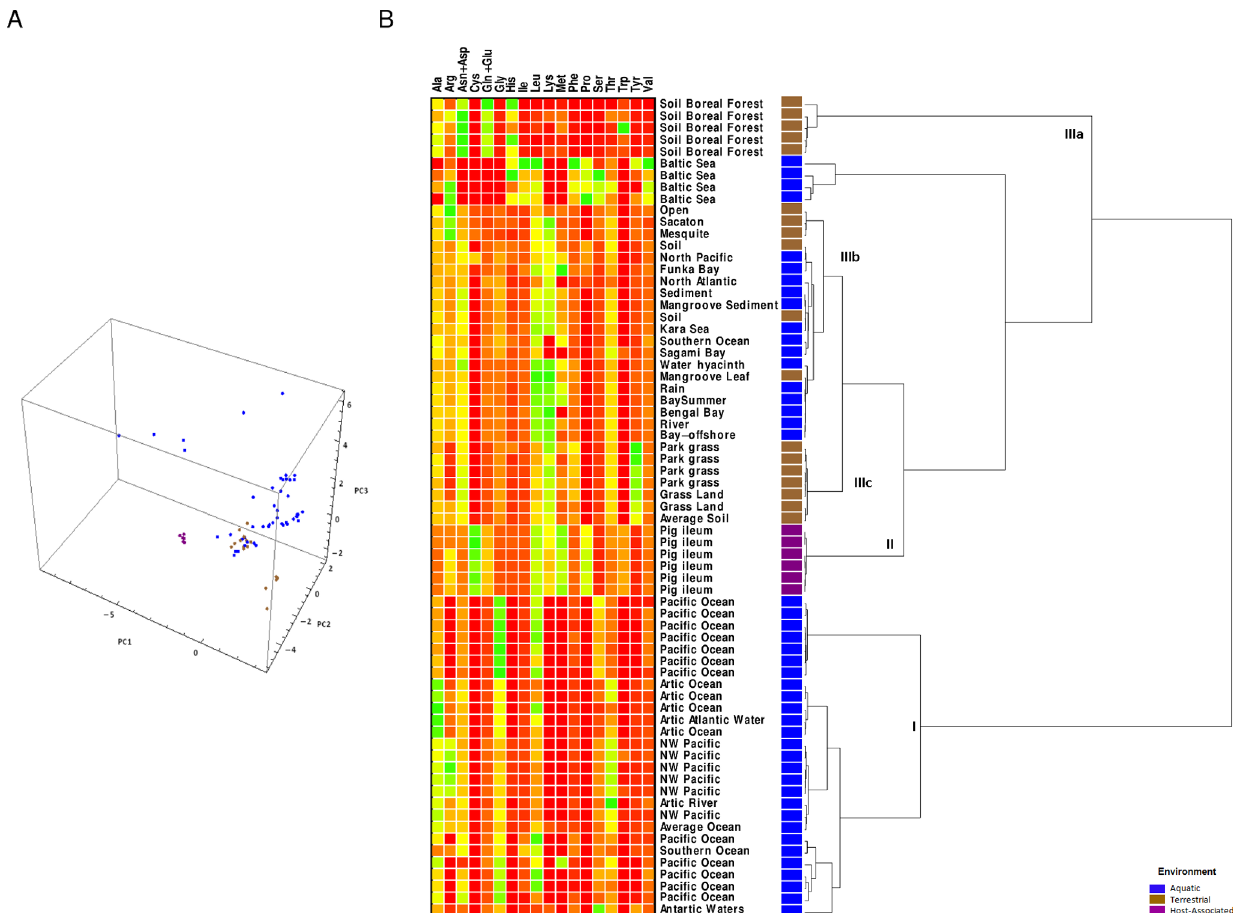
Figure 1. Characterization of different environments by their relative amino acid composition. A) scatter plot by Principal Component Analysis according to the type of environment; B) Hierarchical clustering analysis. The length of branches represents the degree of dissimilarity between clusters. The x-axis of the heat map represents the 20 amino acids by alphabetical order of the three-letter code name. Determinations of Asp/Asn and Glu/Gln were considered together for the analysis, because environmental measurements did not distinguish between the two amino acids in the pairs. The y- axis of the heatmap represents the individual environments where amino acid abundance was determined. Over- and under- representation of amino acid residues in each environment are represented in green and red colored squares, respectively.